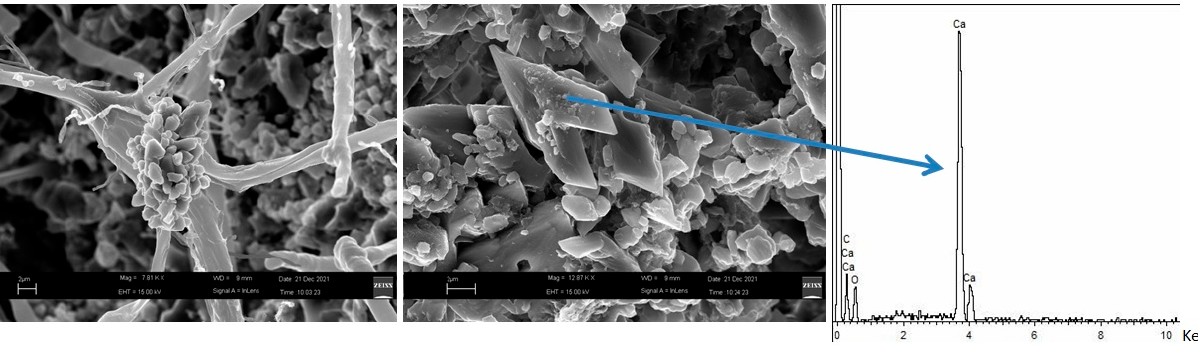
Figure 11. SEM images of calcium carbonate crystals produced by fungal hyphae (left) and of calcite (center) taken from another area of a fragment free of colored patinas, with-related EDS spectrum (right).